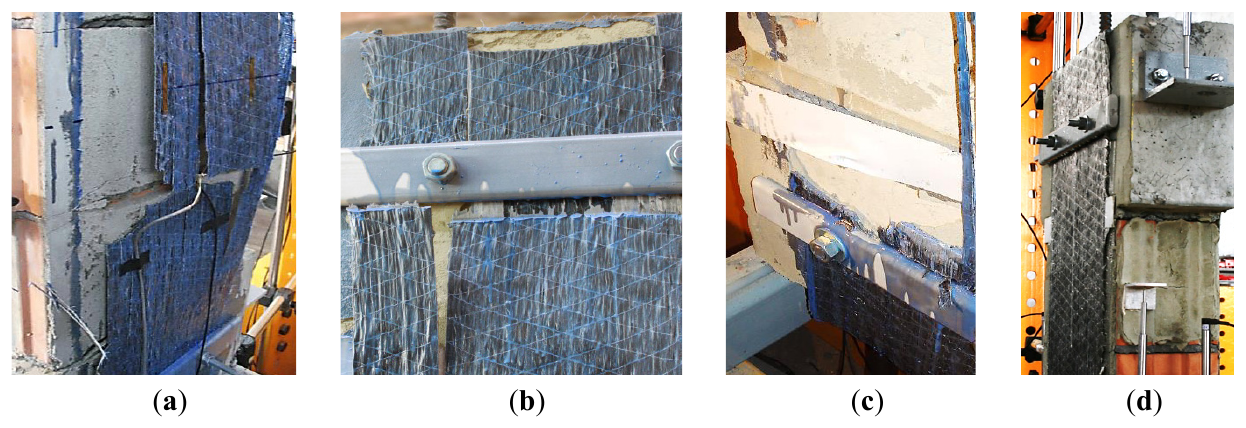
Figure 12. ( a ) Failed specimen AT-F6; ( b ) Failed specimen AT-F11; ( c ) Failed specimen AT-F12; and ( d ) Specimen AT-F9 before